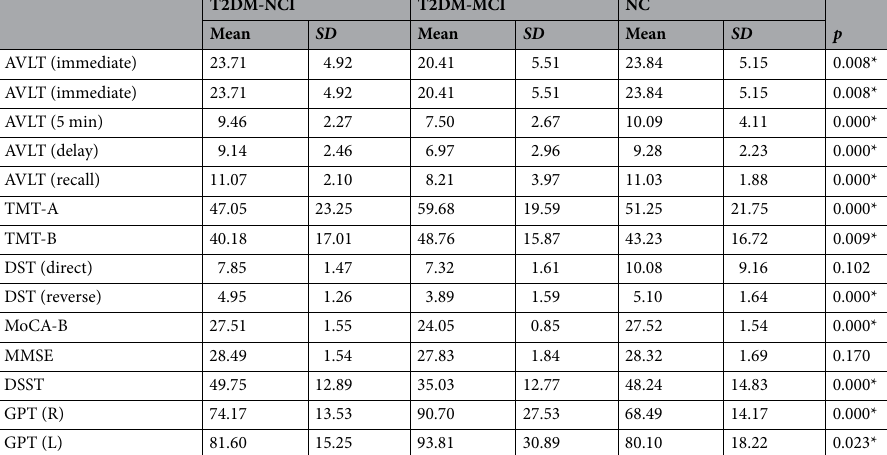
Table 2. Neuropsychological results of T2DM-MCI, T2DM-NCI and NC groups. Data are shown as mean ± standard deviation (SD) and were analyzed using independent sample t-tests. AVLT California-Los Angeles auditory verbal learning test, TMT trail-making test, DST digit span test, MoCA montreal cognitive assessment, MMSE mini-mental state examination, DSST digit symbol substitution, GPT grooved pegboard test, L left, R right. *Data was considered significantly different ( p <